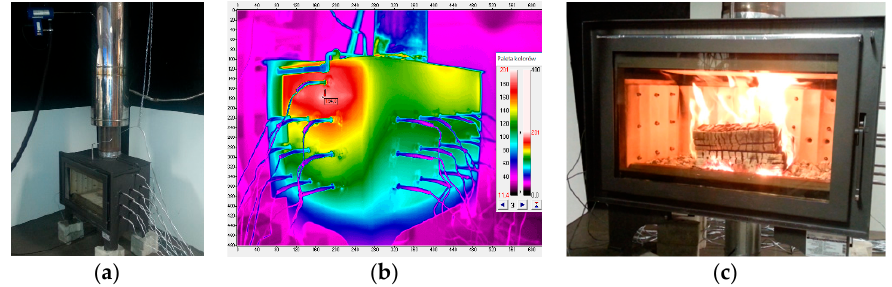
Figure 3. Testing bench facility, experiment: ( a ) fireplace with mounted thermocouples, ( b ) the view from the thermal imaging camera, ( c ) burning process [13].